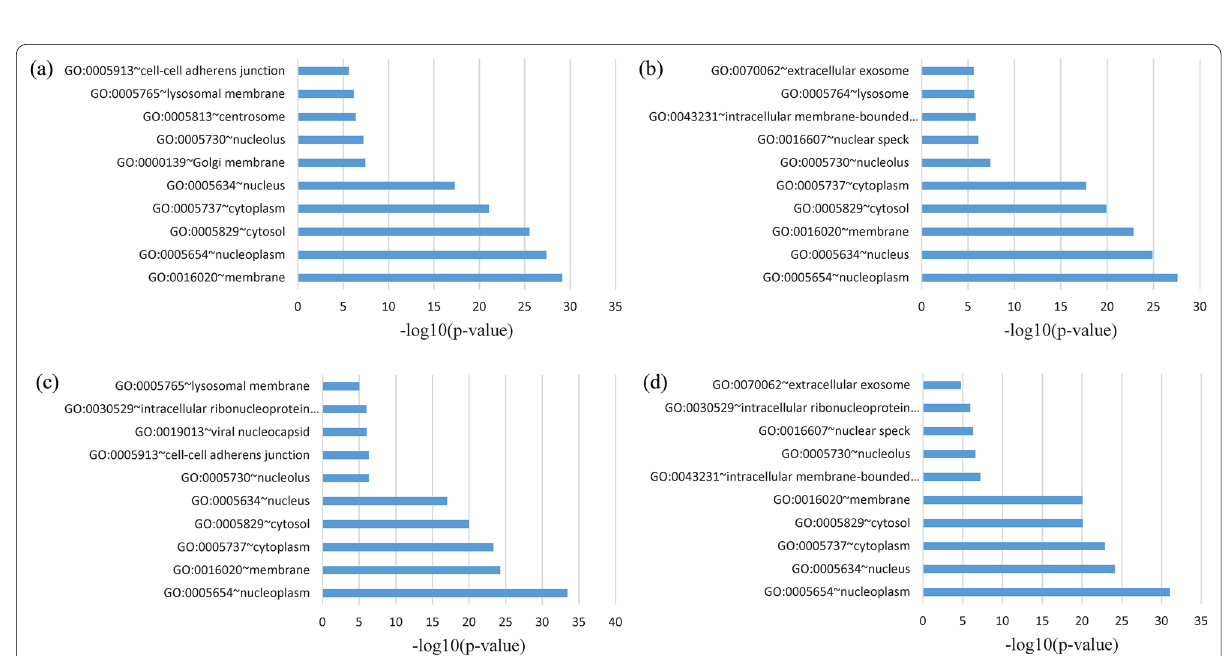
Fig. 3 GO molecular function enrichment analysis of overlapping DEGs: a mild COVID-19 versus CHB, b mild COVID-19 versus HCC, c severe COVID-19 versus CHB, d severe COVID-19 versus HCC